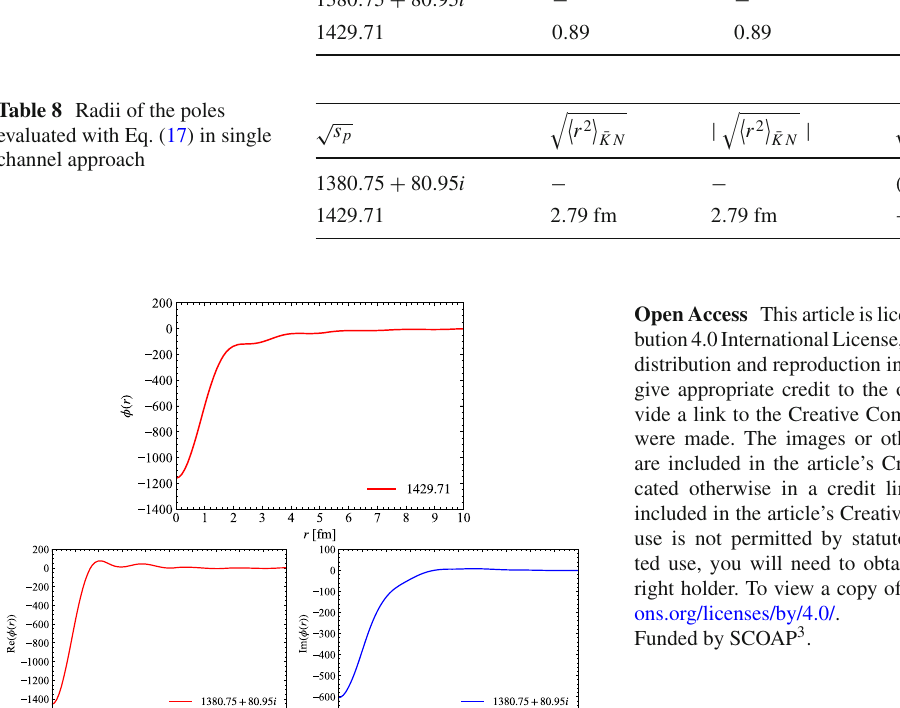
Table 7 Compositeness of the poles in single channel interaction